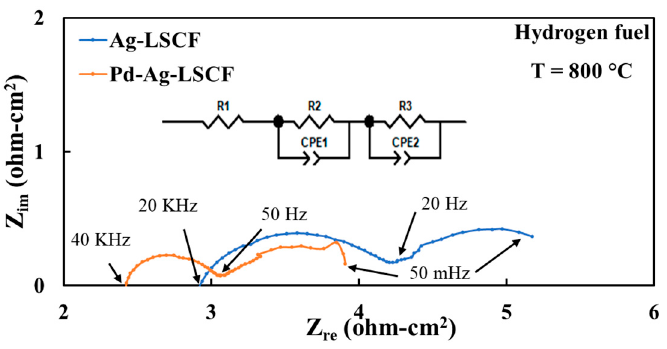
Figure 8. Electrochemical impedance spectra for Ag-LSCF//YSZ//GDC/LSCF cell and Pd-Ag- LSCF//YSZ//GDC/LSCF cell with hydrogen fuel (hydrogen = 75 mL/min, air = 75 mL/min) at 800 °C.